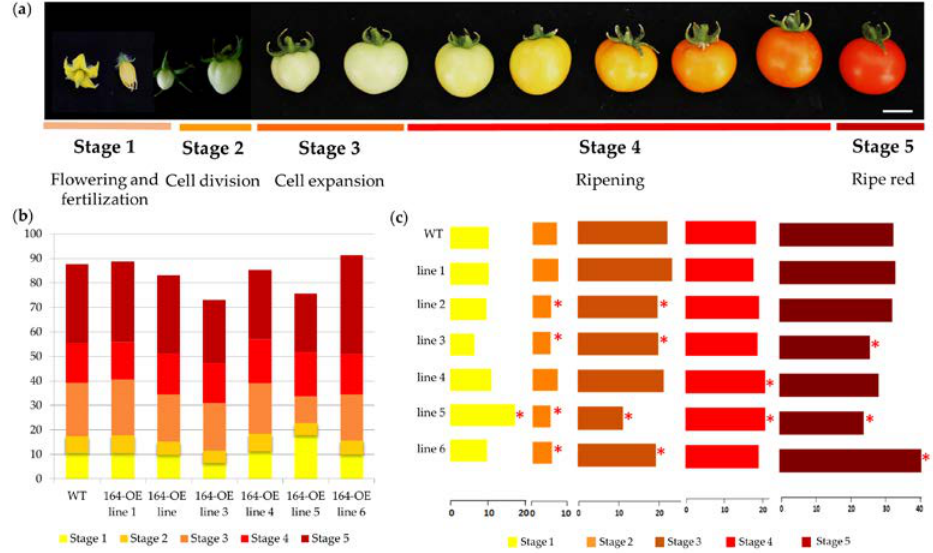
Figure 6. Duration of developmental fruit stages in 164-OE tomato lines. ( a ) Overview of tomato MT- Rg1 fruit development; ( b ) Total duration of tomato MT- Rg1 fruit development; ( c ) Time required for some specific stages of tomato fruit development. The graph shows the average number of days that the fruits required in each stage during their development. Stage 1 (WT n = 32, line 1 n = 14, line 2 n = 27, line 3 n = 10, line 4 n = 3, line 5 n = 19, line 6 n = 50). Stage 2 (WT n = 208, line 1 n = 106, line 2 n = 76, line 3 n = 66, line 4 n = 26, line 5 n = 43, line 6 n = 71). Stage 3 (WT n = 216, line 1 n = 107, line 2 n = 85, line 3 n = 74, line 4 n = 28, line 5 n = 44, line 6 n = 65). Stage 4 (WT n = 207, line 1 n = 120, line 2 n = 105, line 3 n = 83, line 4 n = 27, line 5 n = 40, line 6 n = 61). Stage 5 (WT n = 122, line 1 n = 65, line 2 n = 61, line 3 n = 71, line 4 n = 25, line 5 n = 25, line 6 n = 51). n indicates the number of fruits analyzed. For all cases, the means and LSD intervals at 95% were plotted. * indicates that there is a statistically significant difference. Scale bar = 1 cm.